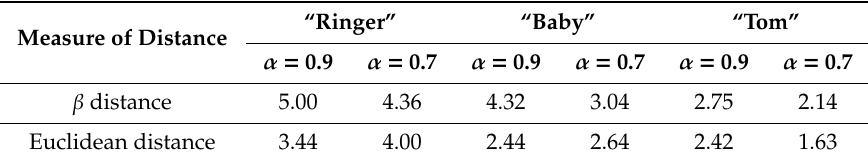
Table 2. The impact of the mixed signal variance used on the perceptual quality of